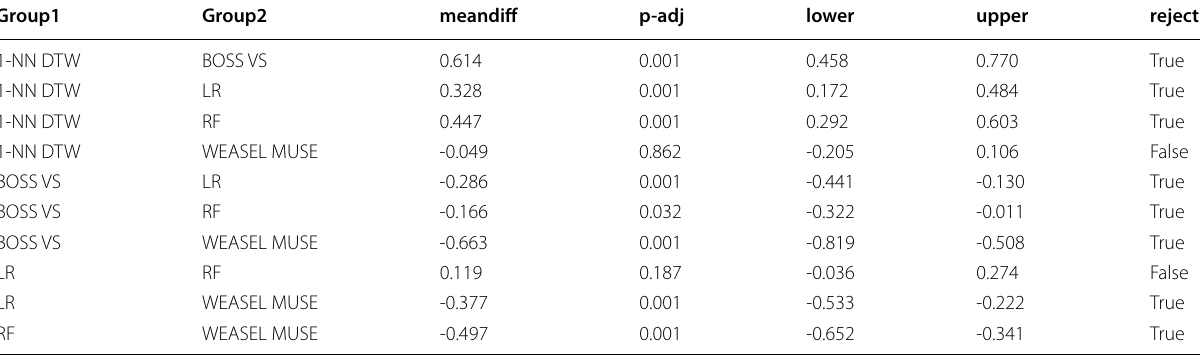
Table 8 Multiple Comparison of Means of Accuracy ‑ Tukey HSD test